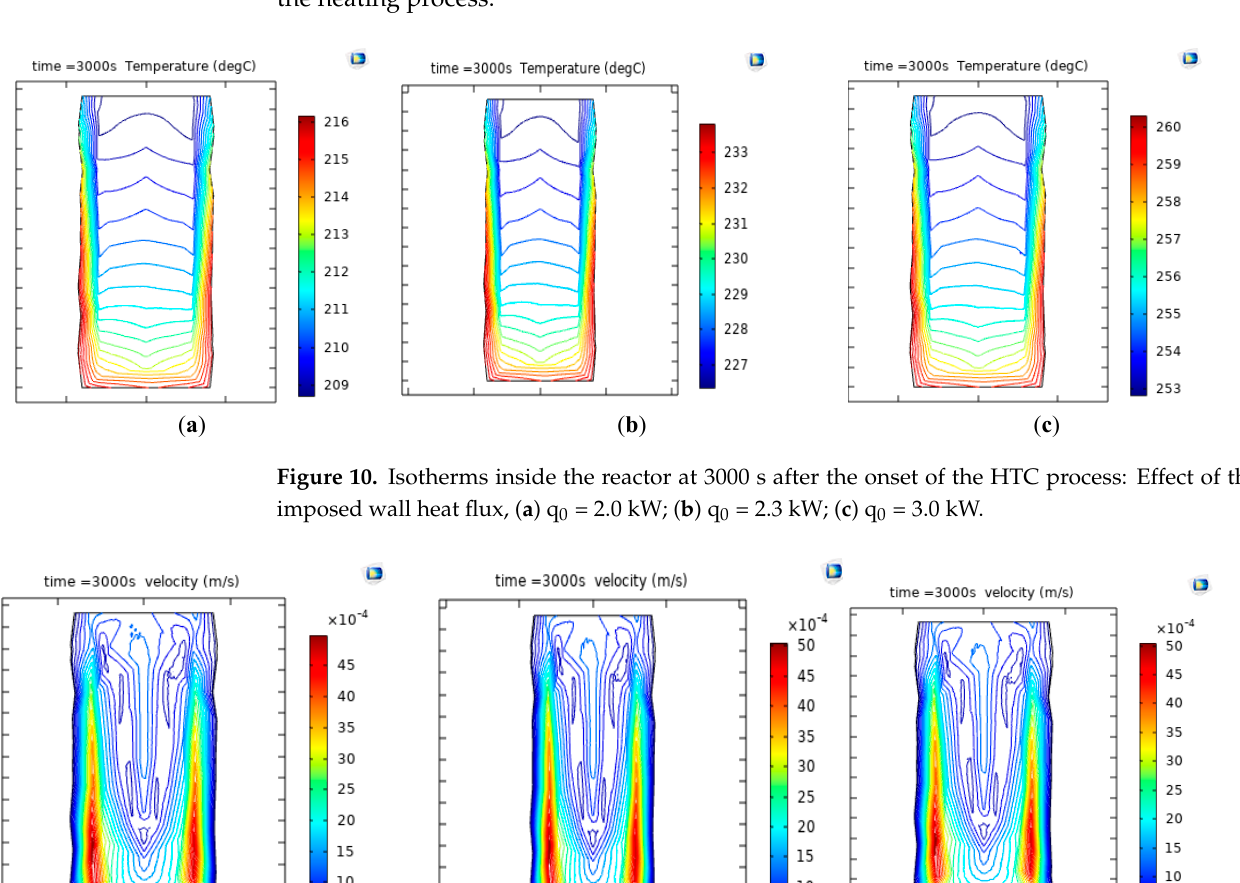
( c ) Figure 12. Isobars inside the reactor at 3000 s after the onset of the HTC process: Effect of the im- posed wall thermal power, ( a ) q 0 = 2.0 kW; ( b ) q 0 = 2.3 kW; ( c ) q 0 = 3.0 kW. ( a ) ( c ) Figure 13. Two-dimensional (2D) distribution and velocity of particles inside the reactor at 3000s: Effect of the imposed wall thermal power, ( a ) q 0 = 2.0 kW; ( b ) q 0 = 2.3 kW; ( c ) q 0 = 3.0 kW.